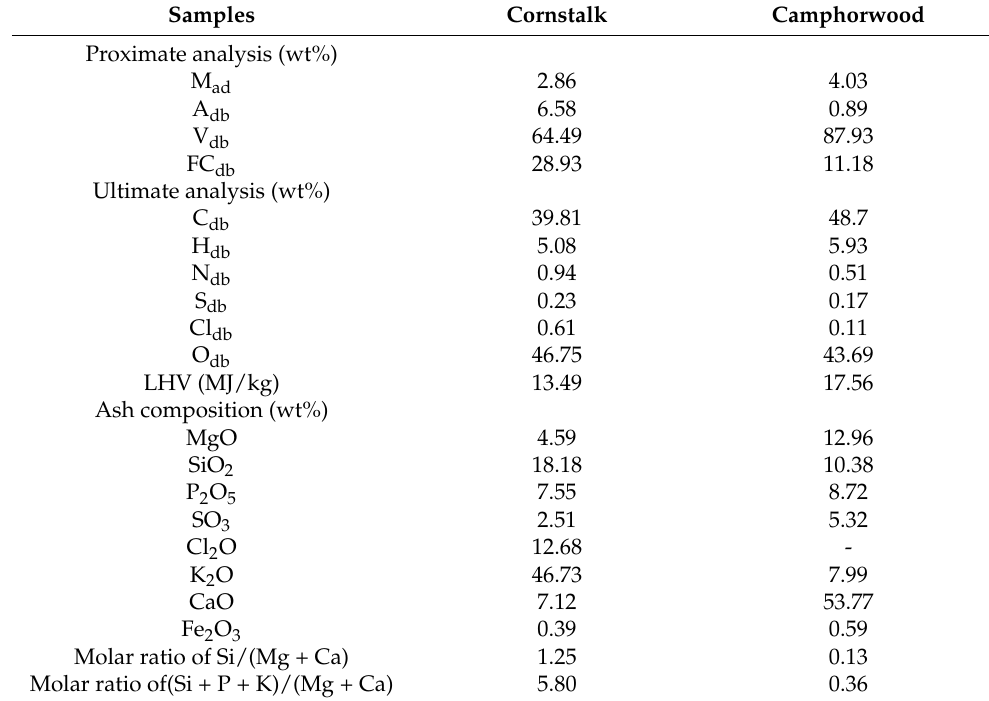
Table 1. Fuel properties and ash